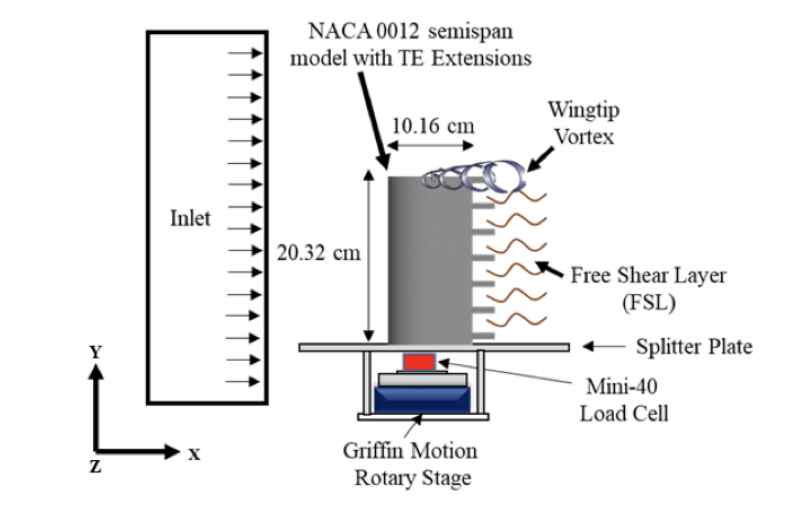
Figure 6. Schematic of the force based experiment test setup for the NACA 0012 semispan model with TE extensions. A similar setup was used for the NACA 0012 wing without TE extensions, as well.